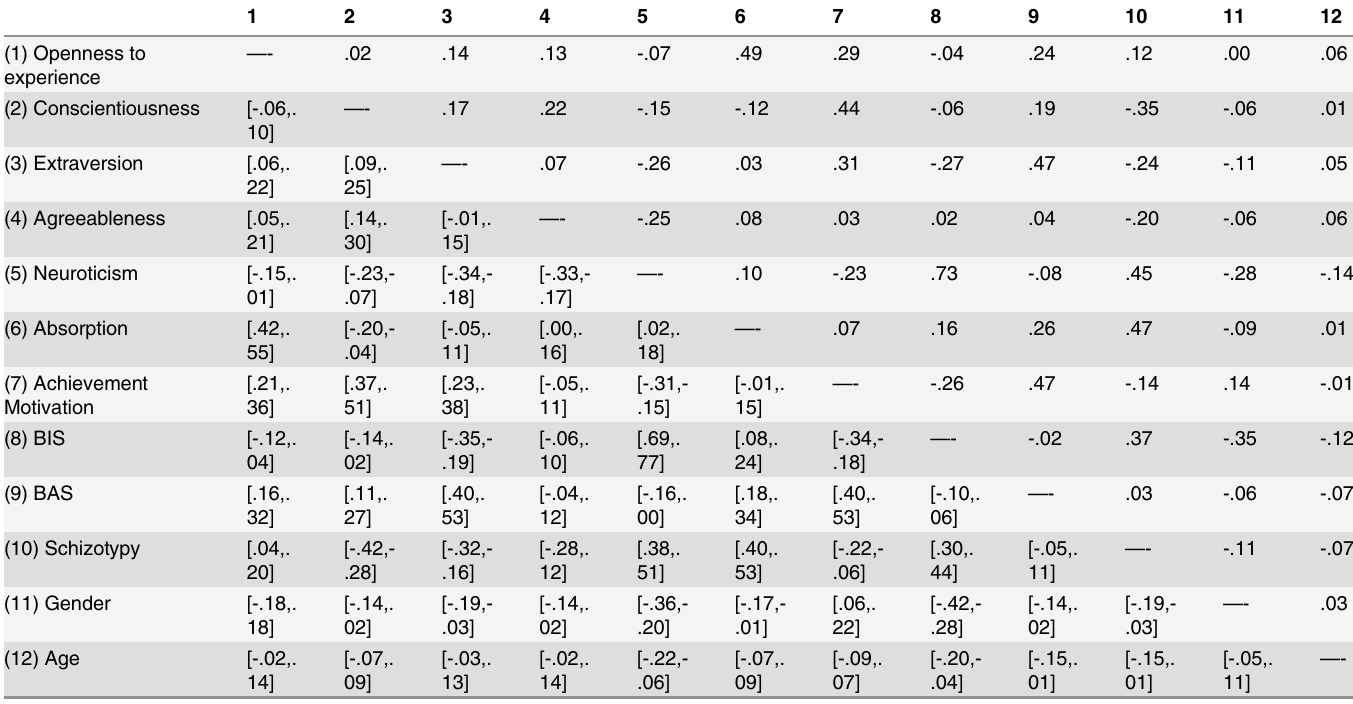
Table 2. Correlations (Pearson ’ s r) among the predictor